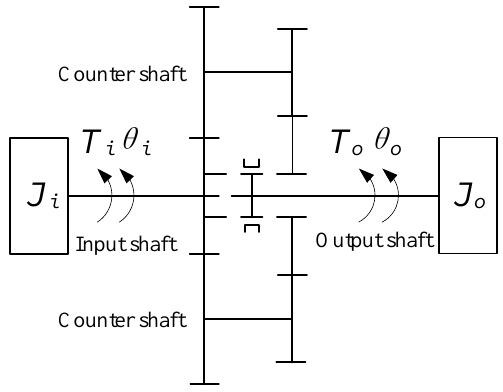
Figure 1. AMT dynamic model under neutral gear position.